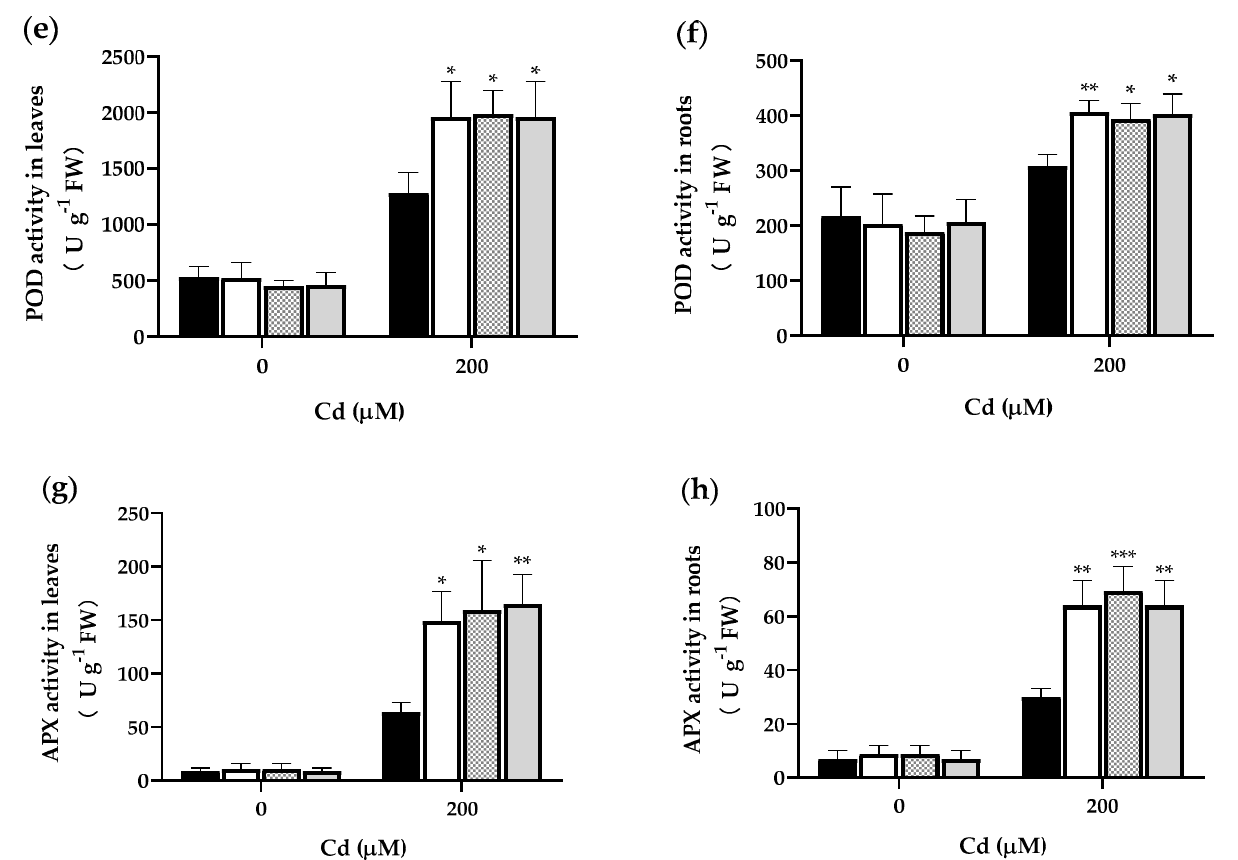
Figure 5. Antioxidant enzyme activities in the leaves and roots of wild-type (WT) and transgenic tobacco plants (OE9, OE11, and OE12). ( a ) CAT activities in leaves. ( b ) CAT activities in roots. ( c ) SOD activities in leaves. ( d ) SOD activities in roots. ( e ) SOD activities in leaves. ( f ) SOD activities in roots. ( g ) APX activities in leaves. ( h ) APX activities in roots. Data represent the means ± SD ( n = 3). The 4-week-old transgenic lines and WT plants were grown in Hoagland nutrient solution containing 0 or 200 μ M Cd for 7 d. Asterisks indicate a significant difference between the transgenic lines and the WT (*, p < 0.05; **, p < 0.01; ***, p < 0.001).